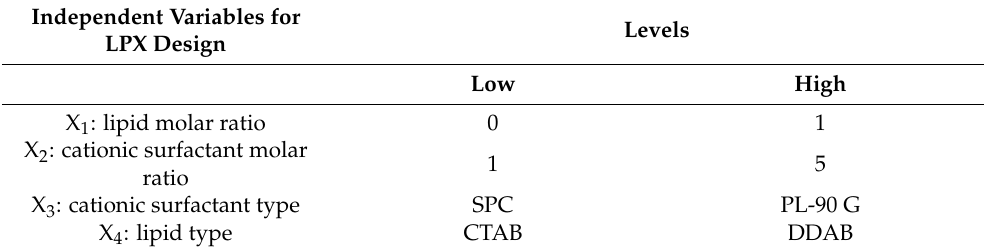
Table 1. DOD of VAN-loaded LPX. Independent Variables